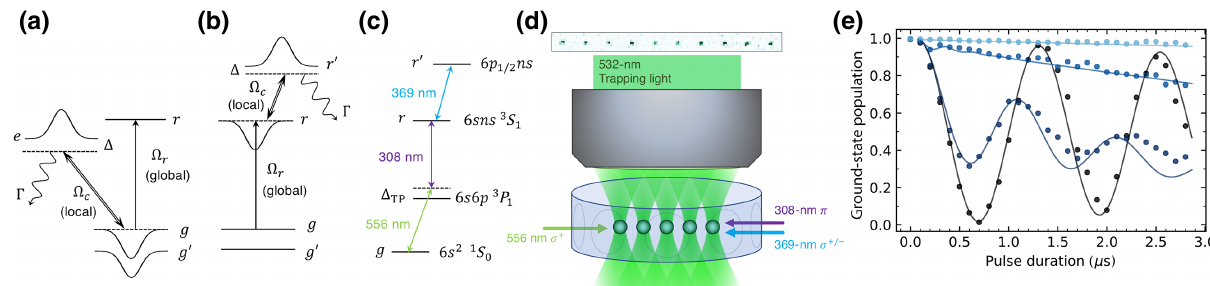
FIG. 1. (a) In the conventional approach to local control with light shifts, the | g (cid:3) → | r (cid:3) transition is detuned via a shift on | g (cid:3) generated by driving the | g (cid:3) → | e (cid:3) transition, using a control field with Rabi frequency (cid:2) c and detuning (cid:3) , where | e (cid:3) has linewidth (cid:4) . A second ground state | g (cid:4) (cid:3) used to encode a qubit will typically also experience a light shift. (b) In the approach presented here, the light shift is generated with a control field tuned near a transition from | r (cid:3) to another highly excited state, | r (cid:4) (cid:3) , which leaves the ground states unshifted. (c) Levels in 174 Yb relevant to this work: | g (cid:3) = 1 S 0 is coupled to the Rydberg state | r (cid:3) = 6 sns 3 S 1 by a two-photon transition through 3 P 1 with intermediate detuning (cid:3) TP = 2 π × 40 MHz. The control field drives the 6 sns → 6 p 1 / 2 ns transition. (d) A schematic of the experiment, indicating the propagation direction and polarization of the driving fields shown in (c). The Rydberg and control beams are focused to approximately 15 μ m 1 / e 2 radius at the position of the atoms. (e) Rabi oscillations between | g (cid:3) and | r (cid:3) (black) are suppressed by the addition of increasing control-beam intensities (black to blue: I c = 0, 15, 90, 600 W/cm 2 ). The solid lines show the result of a numerical